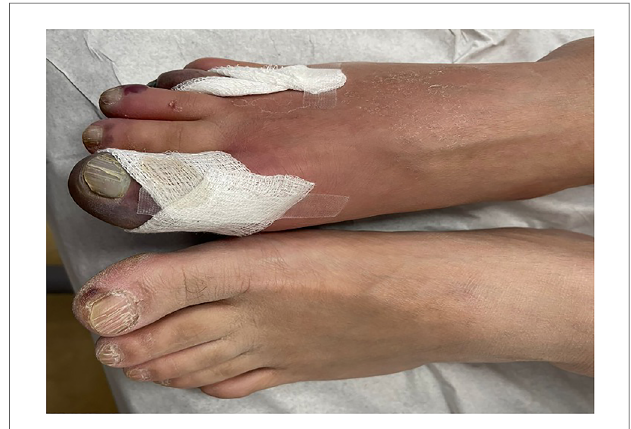
FIGURE 2 CTA of the lower limbs axial view showed right single-vessel posterior tibial artery